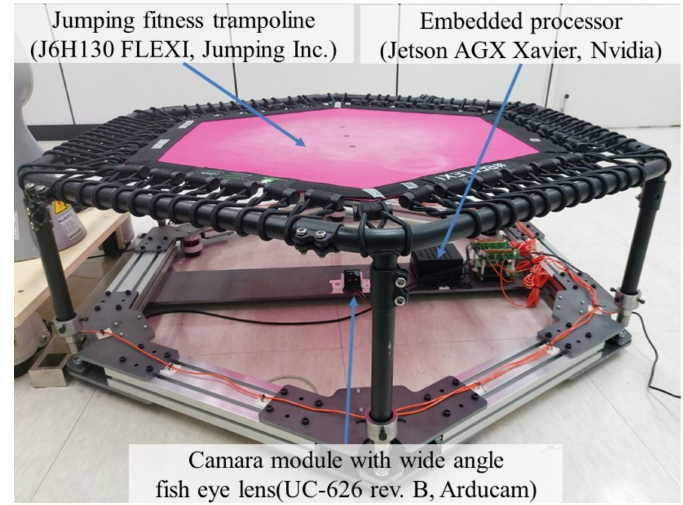
Figure 1. Prototype of a smart trampoline fitness system (STFS).